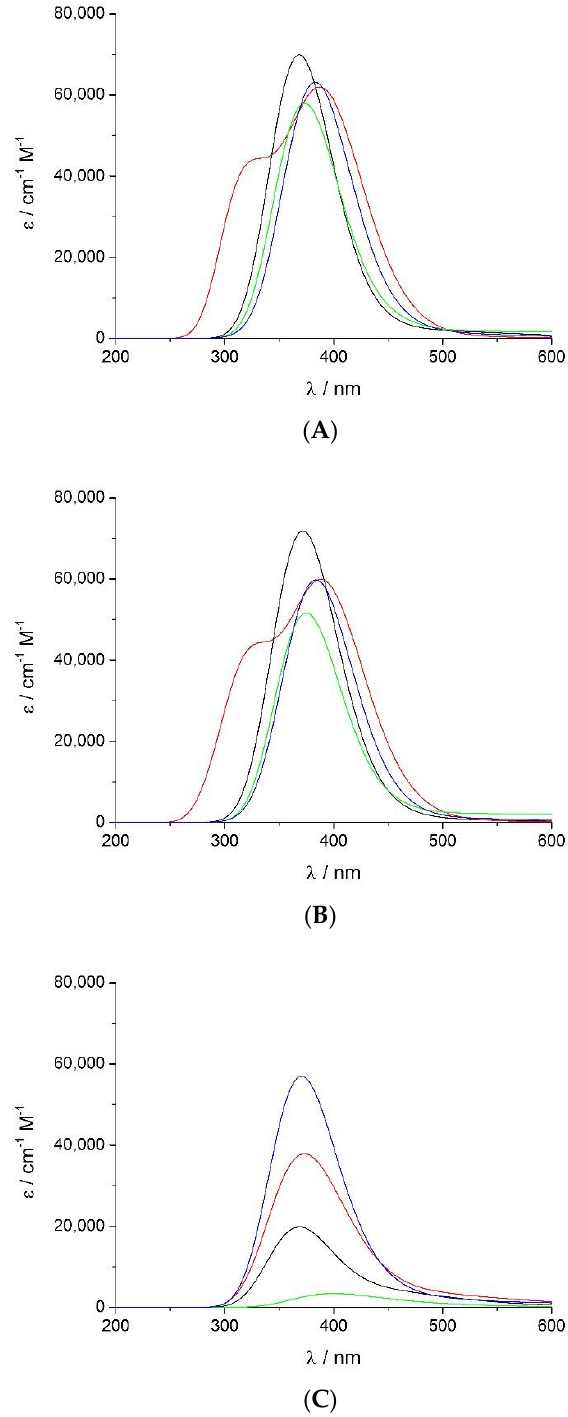
Figure 4. UV-vis spectra at the Soret region calculated by the TD-DFT functional with the B3LYP/cc- pVDZ computational level at the most stable spin state for ( A ) non-protonated Fe(III)-PO ( ─ ), Fe(II)-PO ( ─ ), PO-I ( ─ ), and PO-II ( ─ ); ( B ) corresponding aquo complexes; and ( C ) protonated species.